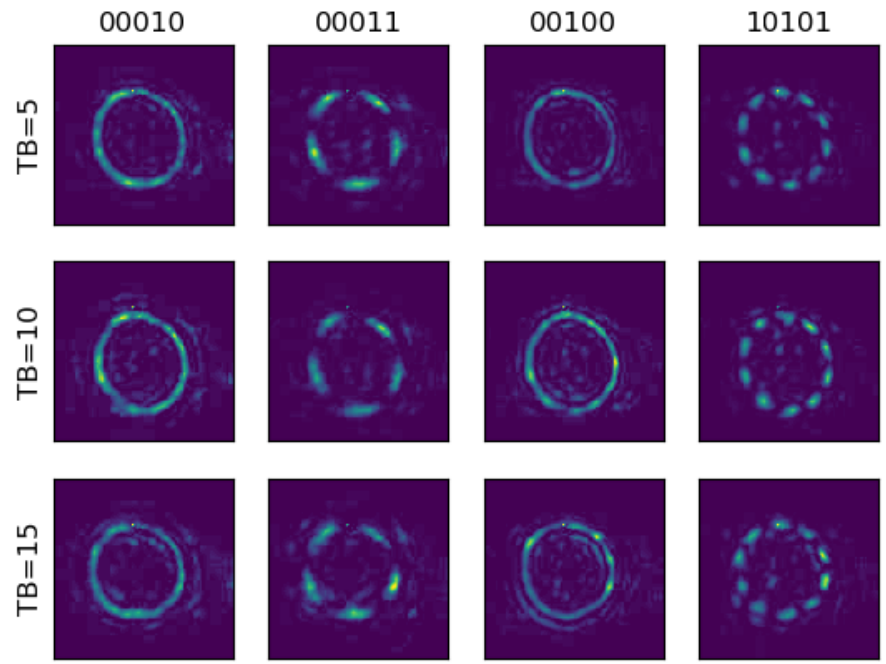
Figure 3. Example of different turbulence levels from the free-space data set. Column header indicates the pattern number and the row label indicates the level of turbulence. Inspecting the different levels for the OAM modes shows pattern displacement or distortion due to the turbulence.